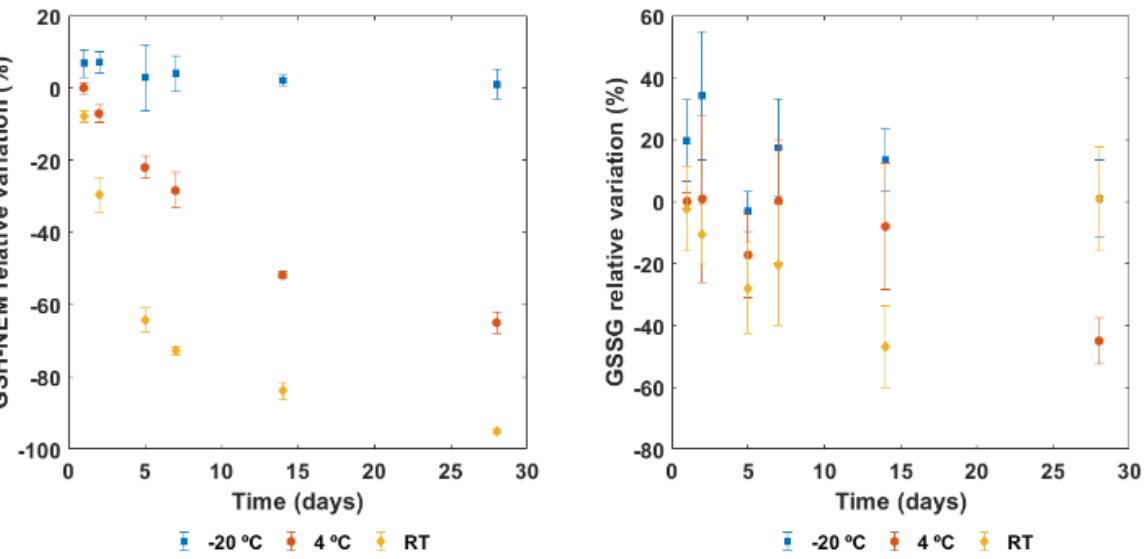
Figure 4. GSH-NEM and GSSG relative variation testing three different conditions (room temperature (RT), 4 °C, and − 20 °C) from 1 to 28 days.